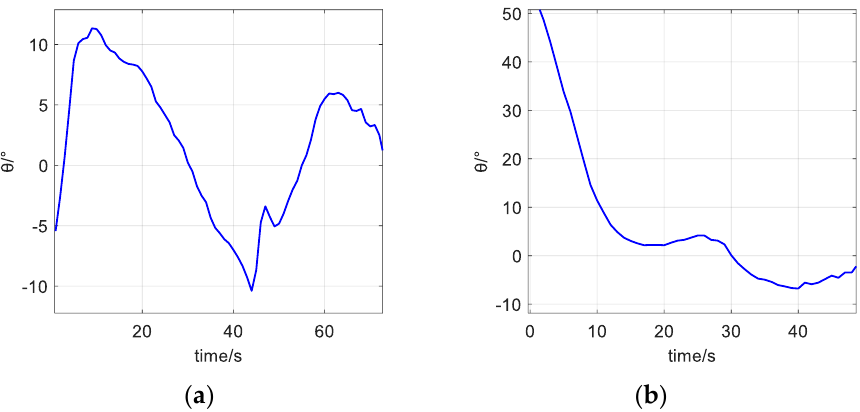
Figure 21. Heading angle variations curve of ASV: ( a ) forward, ( b ) left and forward.